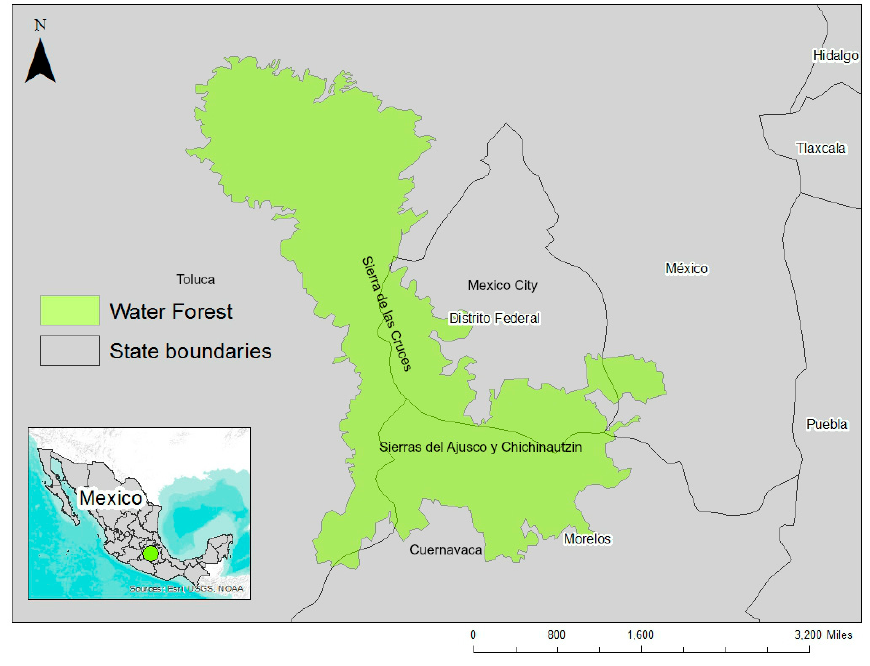
Figure 1. Water Forest extension and location of the main cities map. Source: Extracted from Ornelas-Lopez [28]. Table 1. Population, extraction, and economic uses of 10 aquifers in Central Mexico.